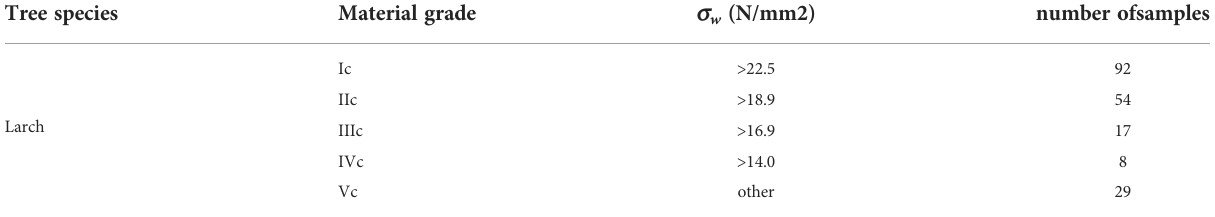
TABLE 1 Standard for classi fi cation of larch properties. Tree